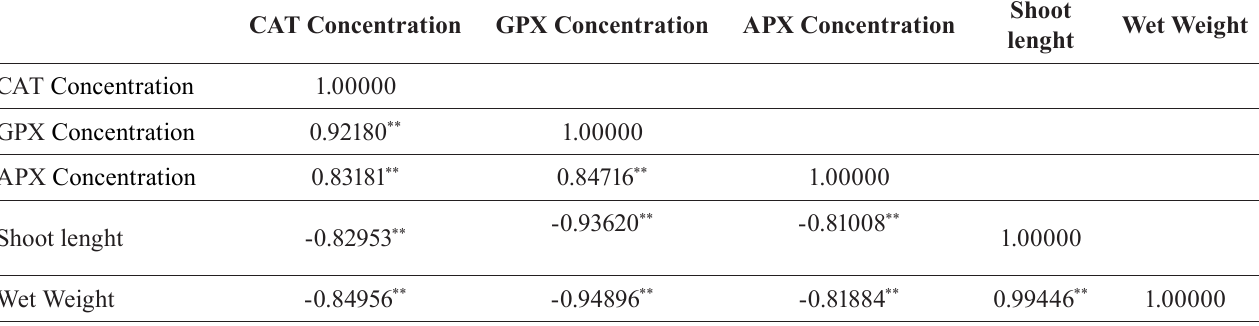
CAT Concentration GPX Concentration